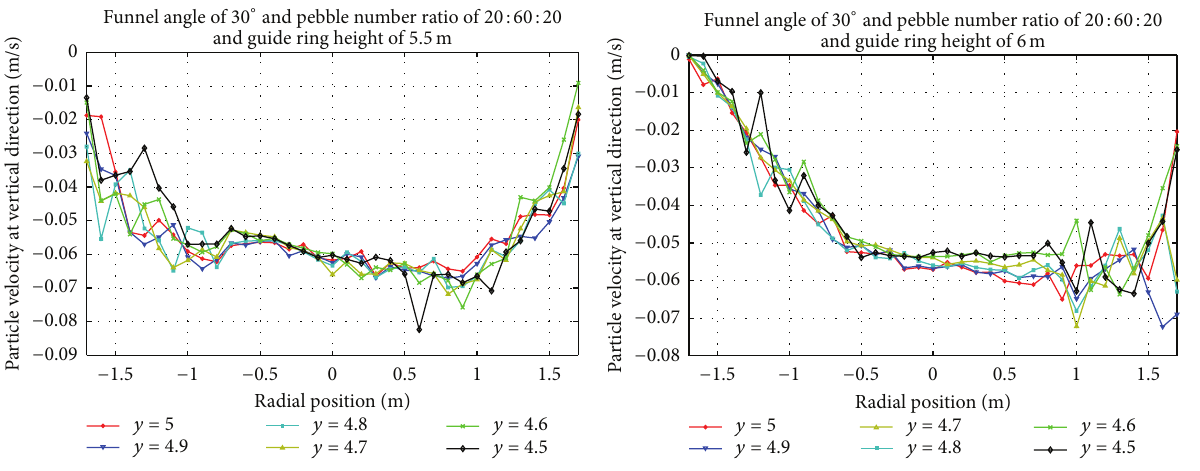
(b) Vertical velocity distribution of pebbles with guide ring of 6m at upper region